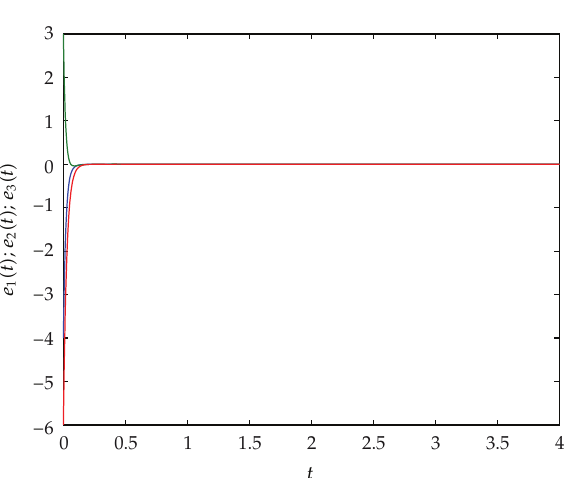
Figure 3: Synchronization errors of systems (cid:3) 2.1a (cid:4) – (cid:3) 2.1d (cid:4) and (cid:3) 2.2a (cid:4) – (cid:3) 2.2d (cid:4) with a (cid:8) 0 . 4 and Δ φ i (cid:3) u i (cid:4) (cid:8) u i , ∀ i ∈ { 1 , 2 , 3 } , under the control of (cid:3) 2.6 (cid:4) .